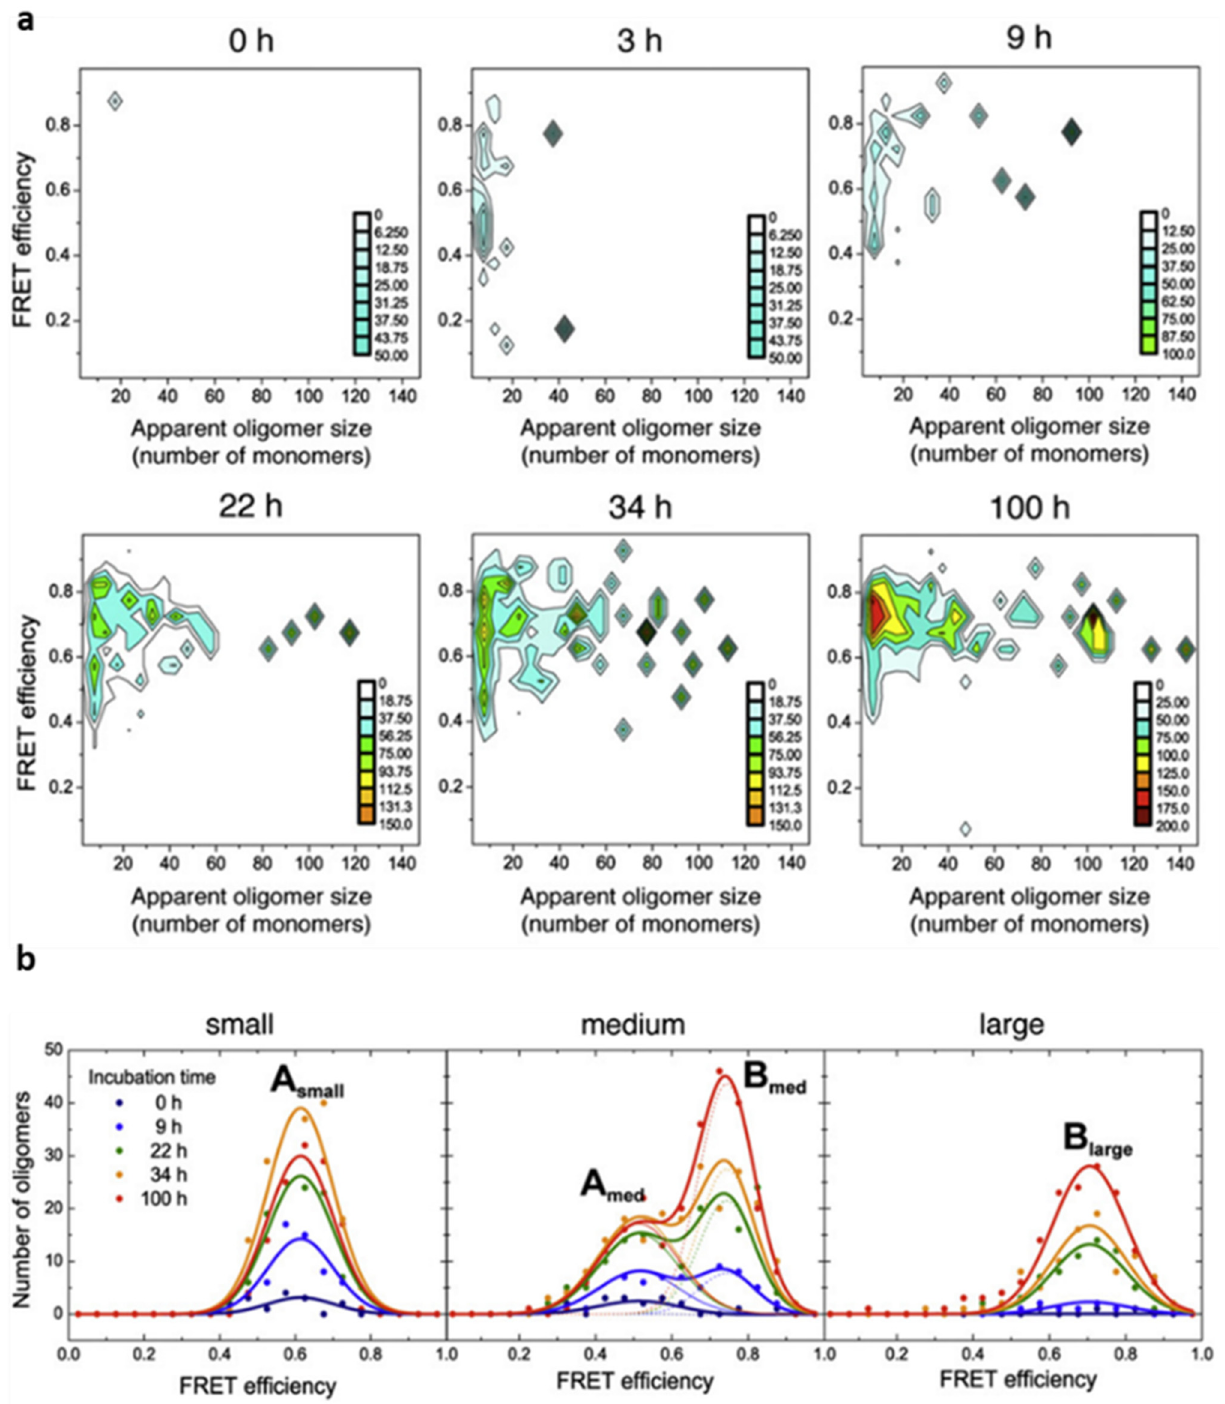
Figure 3. α S oligomer populations present during fibril formation process obtained by diffusion- based single-molecule fluorescence approaches. ( a ) Two-dimensional (2D) plots corresponding to the apparent oligomer size versus FRET efficiency at different incubation times under aggregation- promoting conditions obtained by TCCD-smFRET analysis. ( b ) Representation of the global analy- sis of FRET-derived oligomer populations, classified according to their size, over incubation time. Adapted with permission from Figure 2A,C, Cremades, N.; et al. Cell , 2012, 149 , 1048-59, doi: 10.1016/j.cell.2012.03.037, published under Creative Commons Attribution 3.0 Unported (CC BY 3.0) [23].